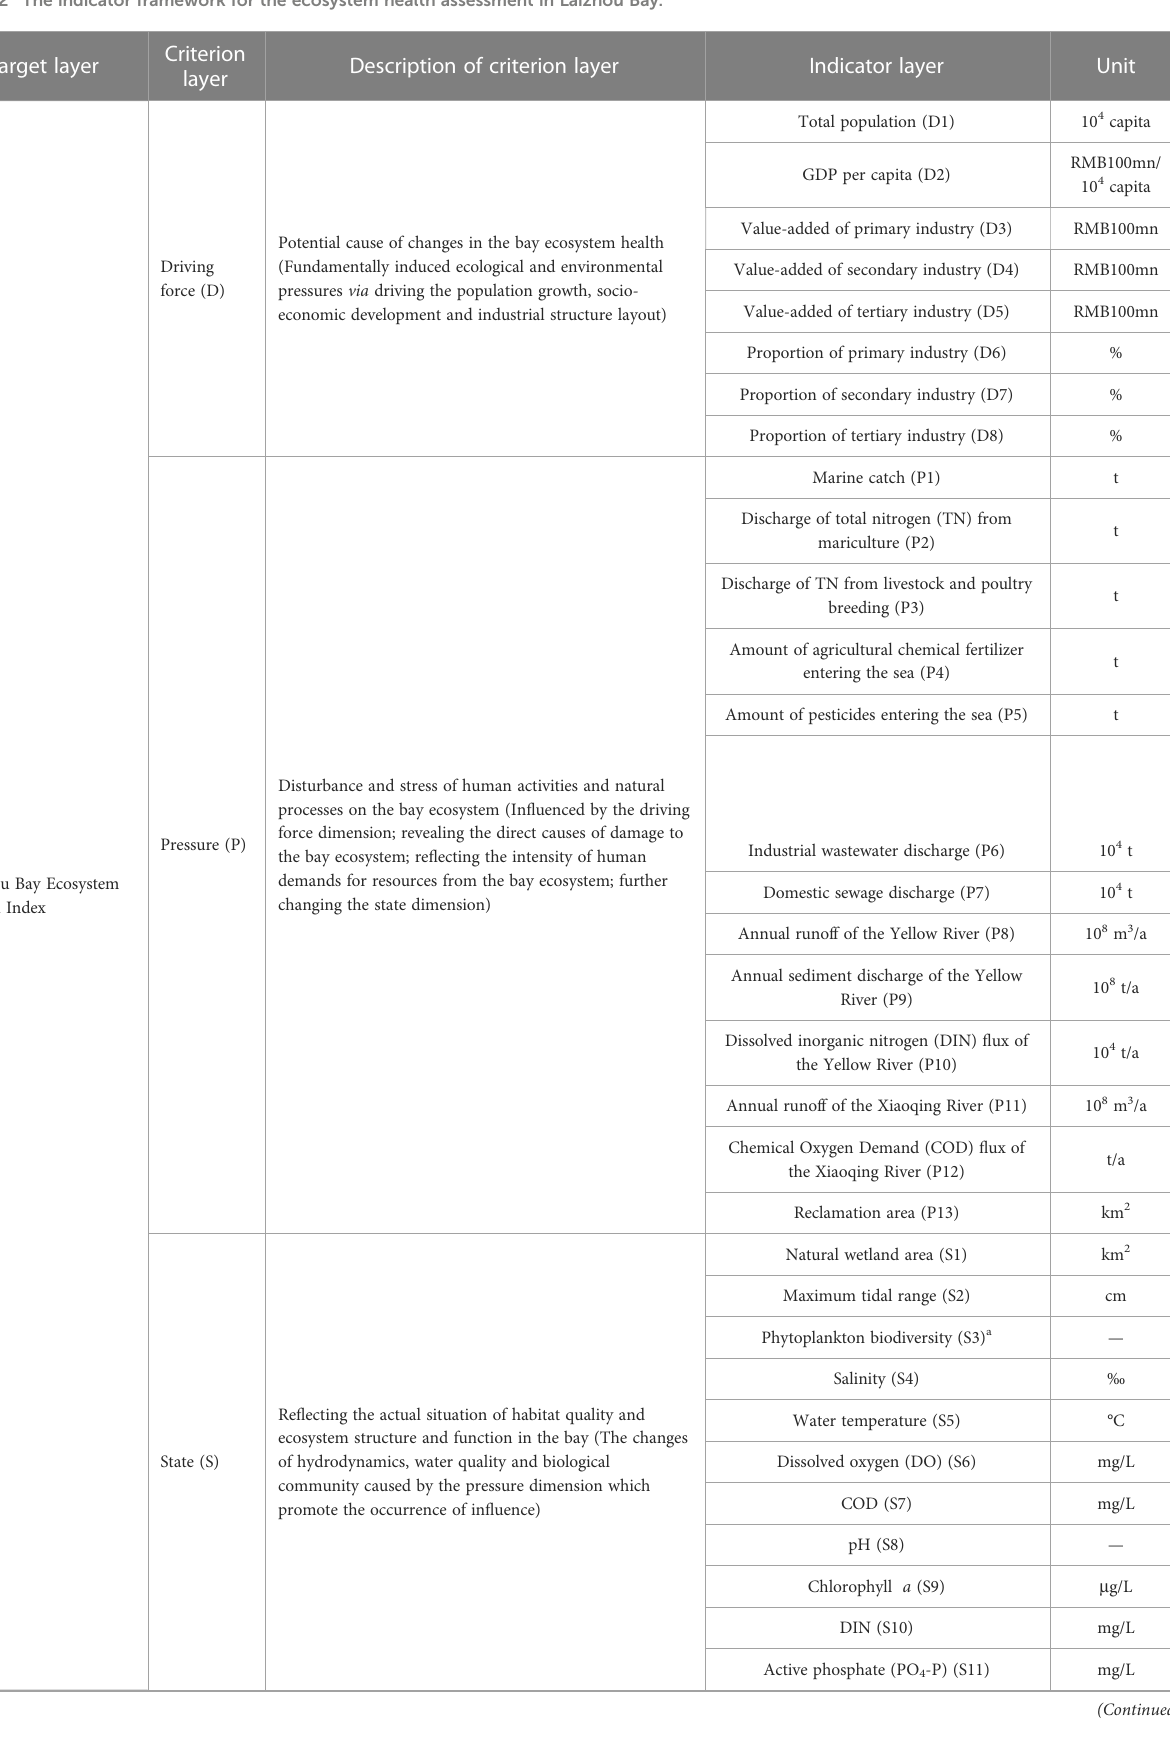
TABLE 2 The indicator framework for the ecosystem health assessment in Laizhou